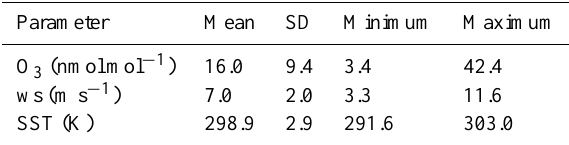
Table 2. Summary of the O 3 and ancillary parameters measured during Malaspina 2010. The data correspond to daytime average values concurrent with the IO measurements gathered during the expedition (Fig.